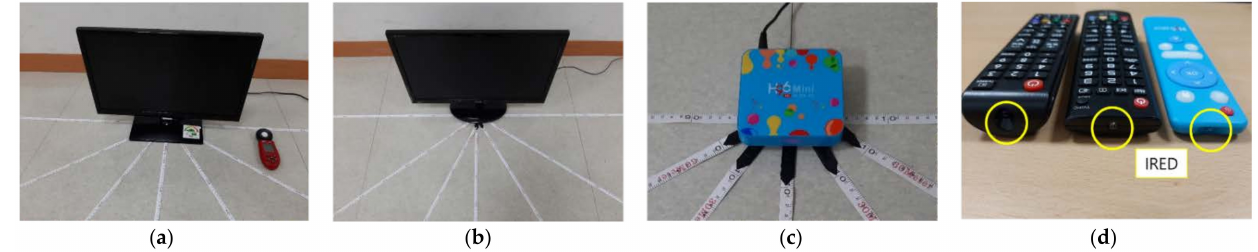
Figure 4. Experimental gadgets. ( a ) Samsung TV. ( b ) LG TV. ( c ) Set-top box. ( d )